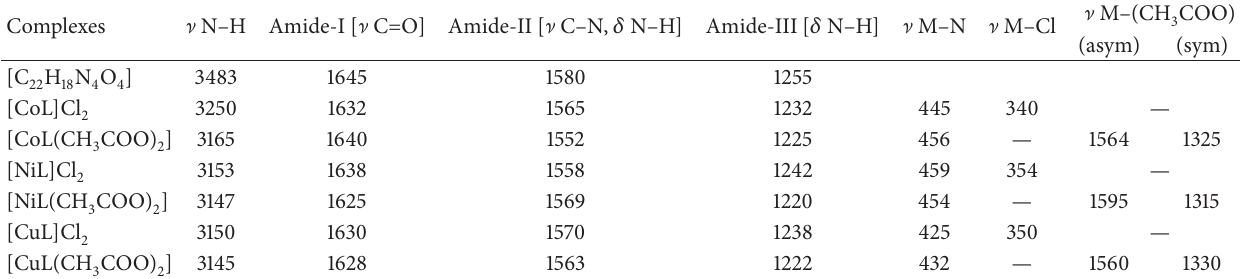
Table 3: Relevant IR spectral peaks (cm − 1 ) and their assignments.